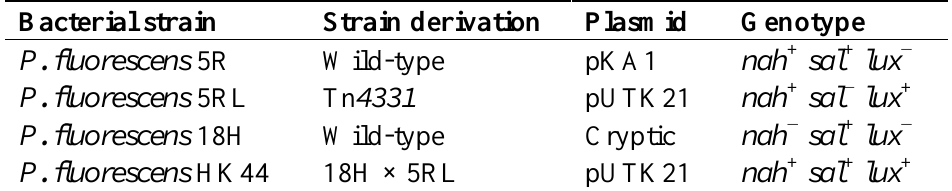
Table 2. Bacterial strains and plasmids used to construct P. fluorescens